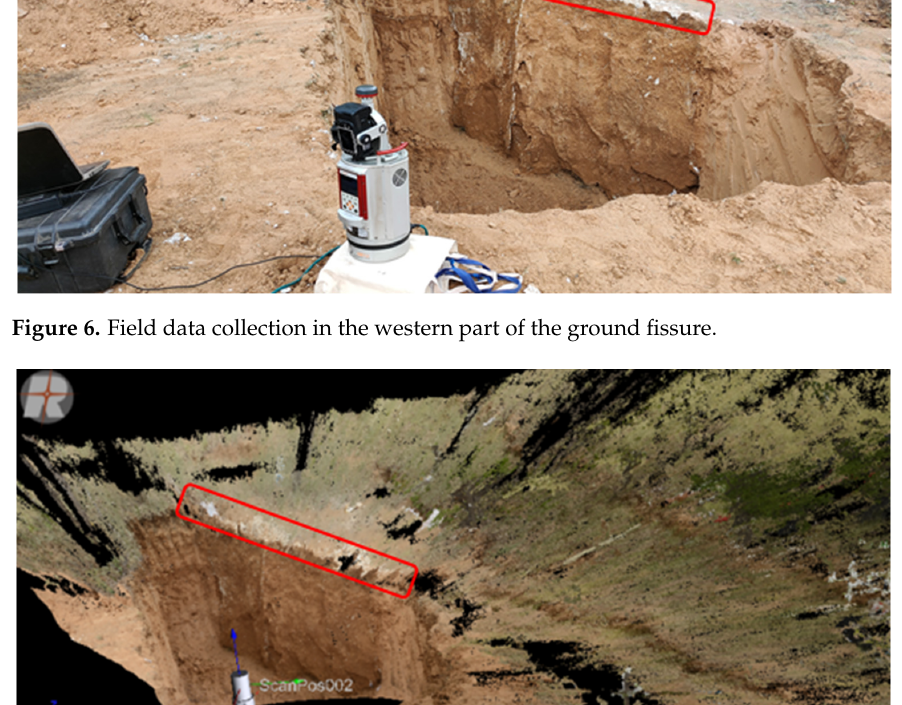
( d ) Figure 8. 3D modeling of the ground fissure: ( a ) Front view of the ground fissure; ( b ) Left view of the ground fissure; ( c ) Top view of the ground fissure; ( d ) 45-degree side view of the ground fissure. 1.